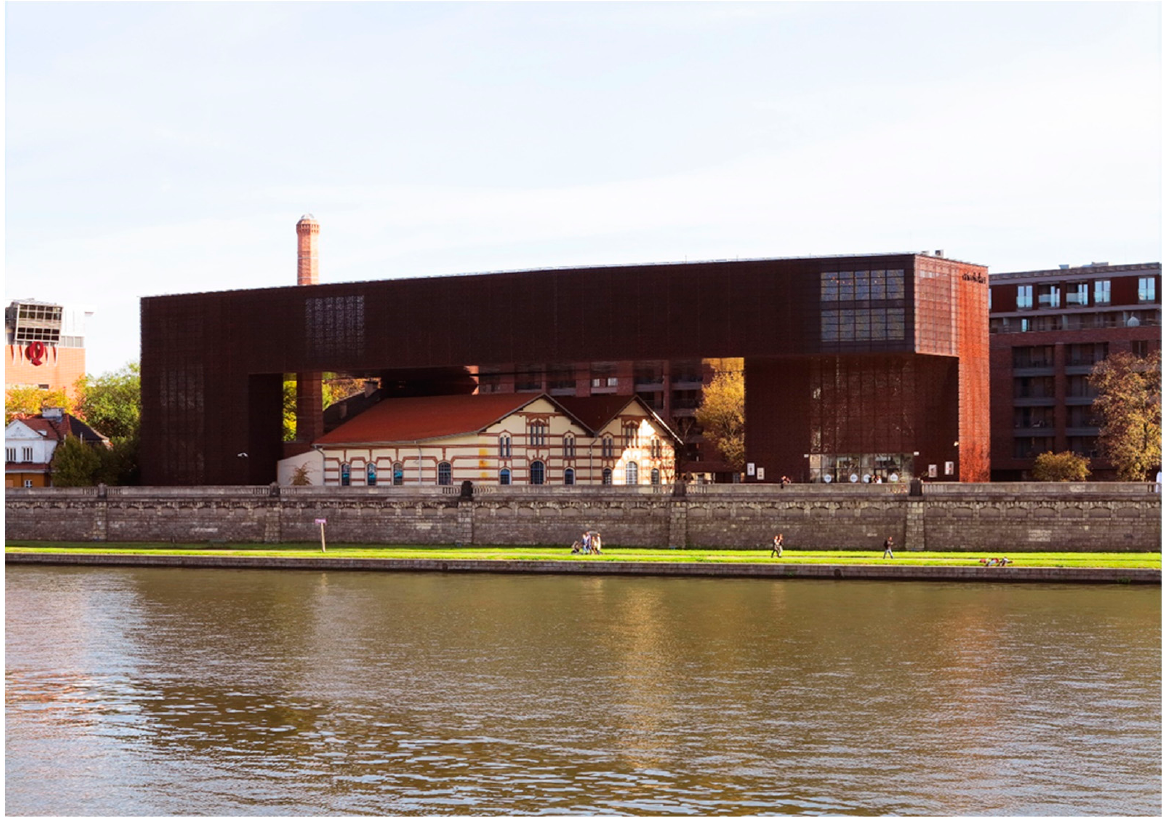
Figure 8. CRICOTEKA Centre for the Documentation of the Art of Tadeusz Kantor in Kraków, photo by Michał Pieczka.